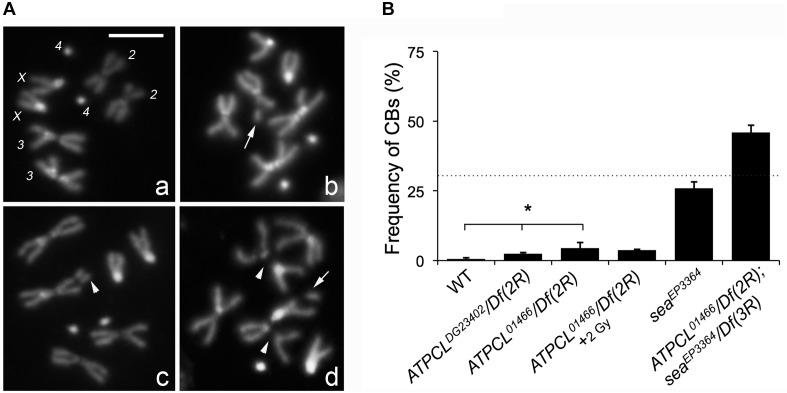
Depletion of ATPCL yields to chromosome breaks (CBs). (A) DAPI-stained female metaphases from larval neuroblasts of control (Oregon R, a), ATPCL mutants (b,c) and ATPCL, sea double mutants (d). Numbers in (a) indicate chromosomes X, 2, 3, and 4 of a normal female caryotype. White arrows and arrowheads indicated chromatid and CBs, respectively. Bar: 5 μm. (B) Frequency of CBs in ATPCL mutants. All ATPCL mutants exhibit a moderated (although statistically significant) frequency of CBs, which are almost absent in control cells (∗p < 0.05, Student t-test). CBs frequency is not influenced by a 2 Gy X-ray irradiation. Note that the frequency of CBs in ATPCL; sea double mutants is higher than the sum of CB frequencies observed in either ATPCL or sea single mutants (indicated by the dotted line) suggesting a synergistic effect. ∼200 cells (4 slides) for mutant combinations and ∼500 (5 slides) for Oregon R (control) were analyzed. See text for further details. Bars refer to SD.